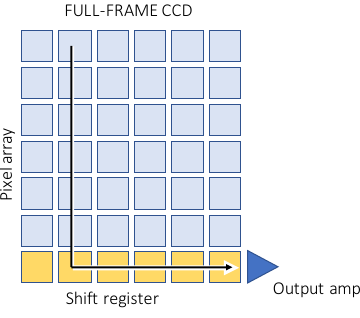
Figure 2. Readout circuit of the full-frame CCD array. Readout is connected to the frame rate. We can double the maximum frame rate, if we read only every second column from the censor